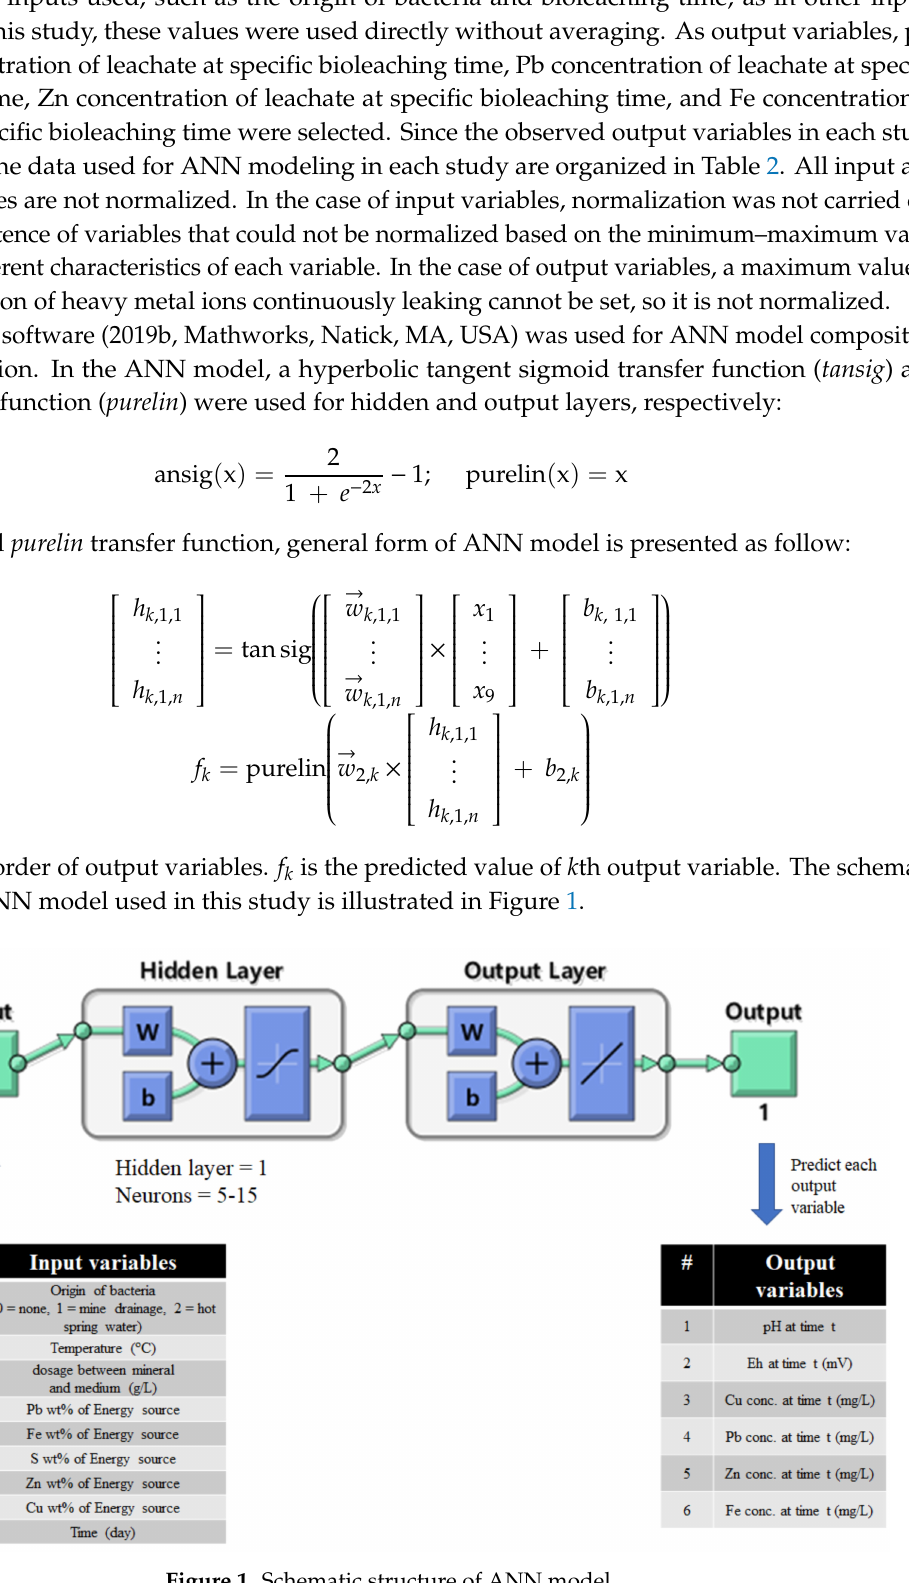
Figure 1. Schematic structure of ANN